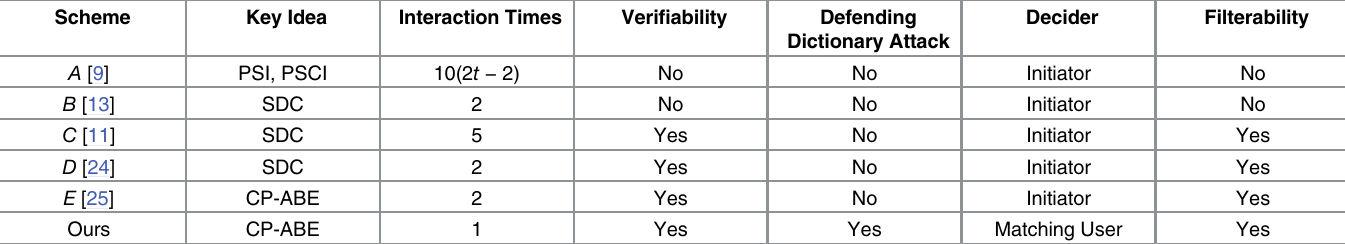
Table 3. Comparison with related schemes.